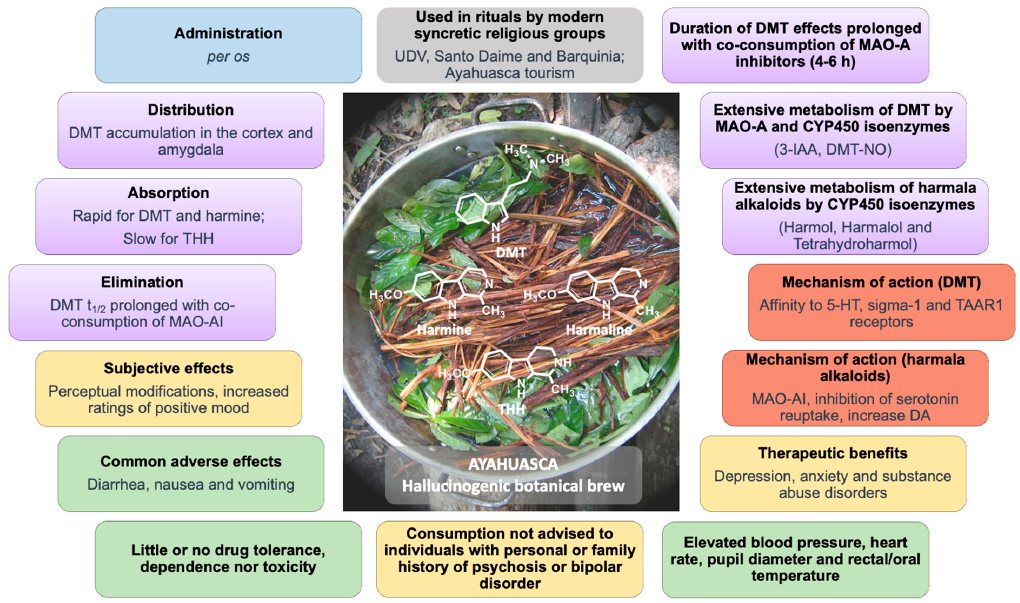
Figure 6. Pharmacokinetic and pharmacodynamic aspects of ayahuasca. 3-IAA: 3-Indole-acetic